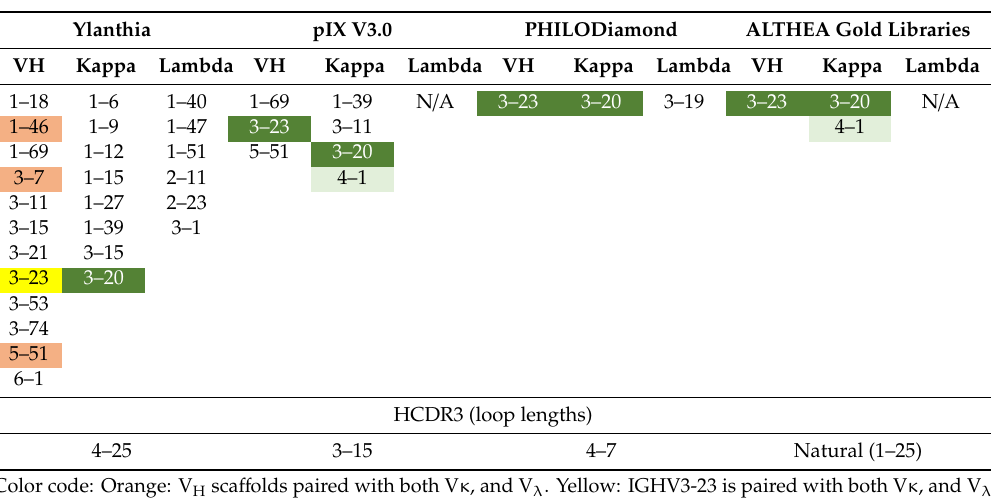
Table 3. V H , V κ , and V λ sca ff olds used as foundations for the synthetic and semisynthetic libraries. We did not include HuCAL PLATINUM in the table since the sca ff olds are not natural germline genes but consensus